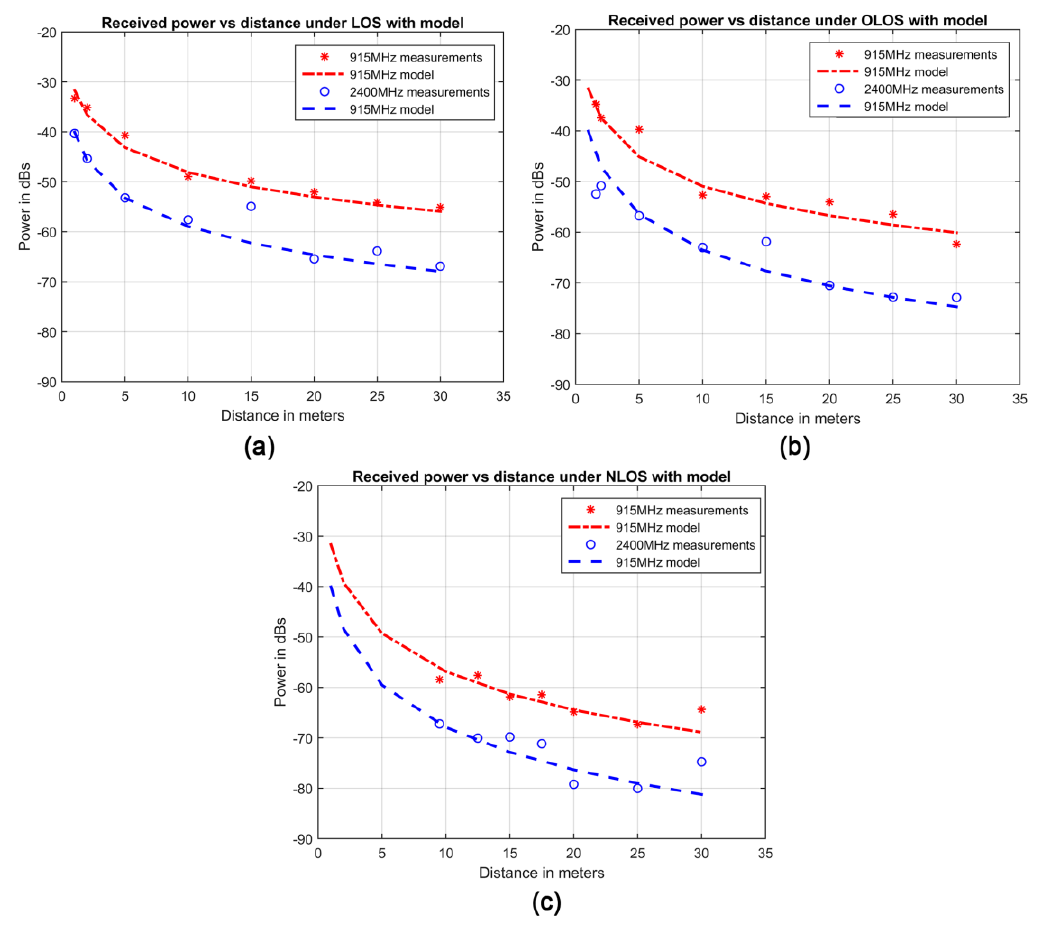
Figure 4. Acquired data and obtained model for ( a ) LOS, ( b ) OLOS, and ( c ) NLOS and both frequency bands.